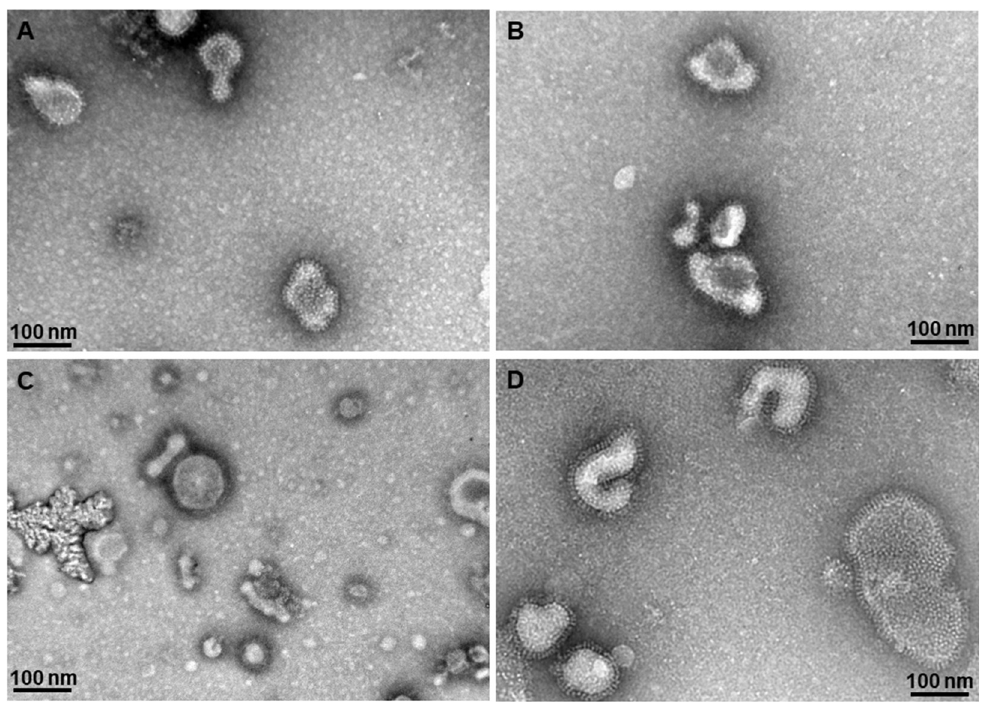
Fig 1. Electron microscopy. T . gondii IMC VLPs (A), ROP18 VLPs (B), MIC8 VLPs (C), and multi-antigen VLPs (D) were examined under transmission electron microscopy. Spherical morphology of VLPs and exhibited antigen spikes on their surfaces were